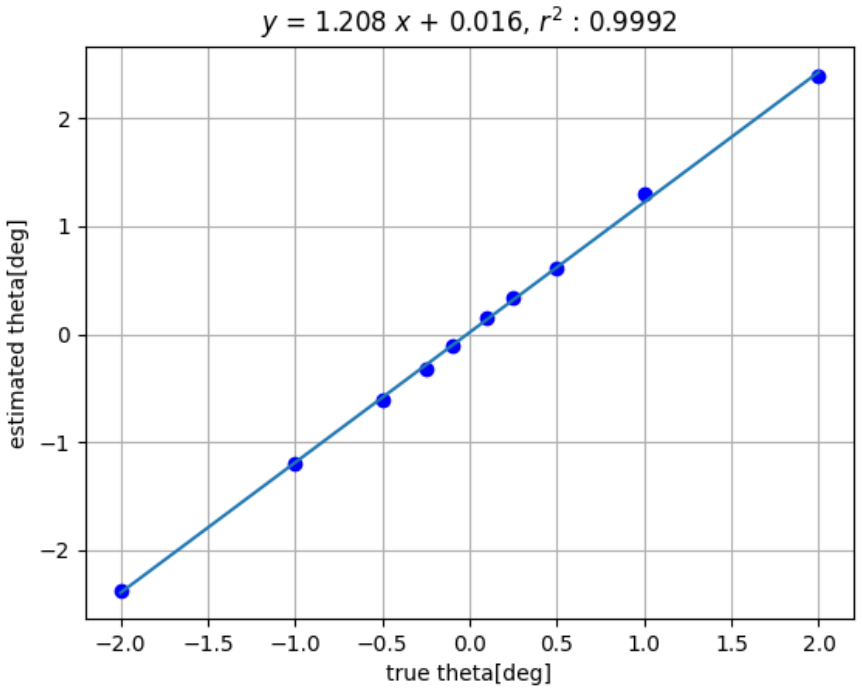
Figure 13. Result of estimation for tilt angle θ by method 2 without camera calibration.